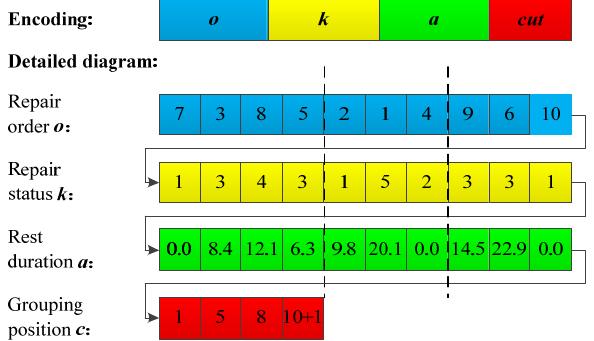
Figure 2. Encoding and decoding diagram.